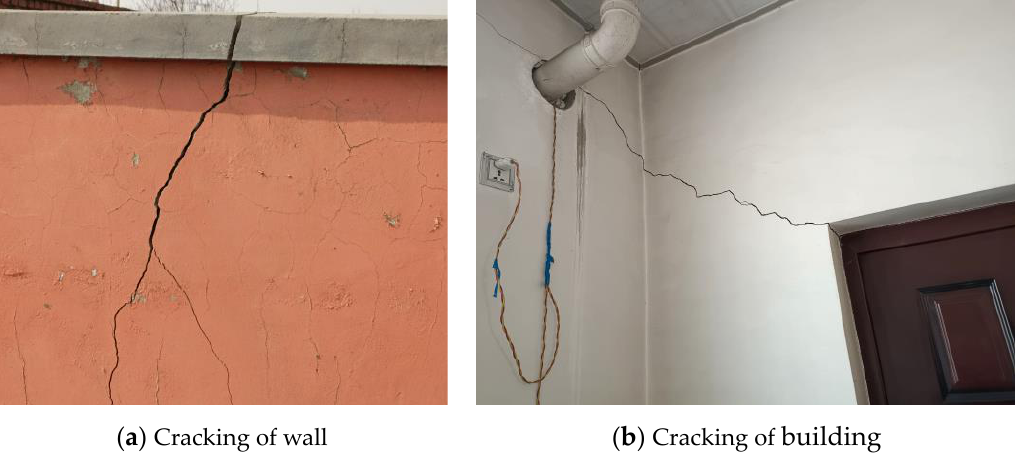
Figure 1. The damage to buildings caused by blast-induced ground vibration.